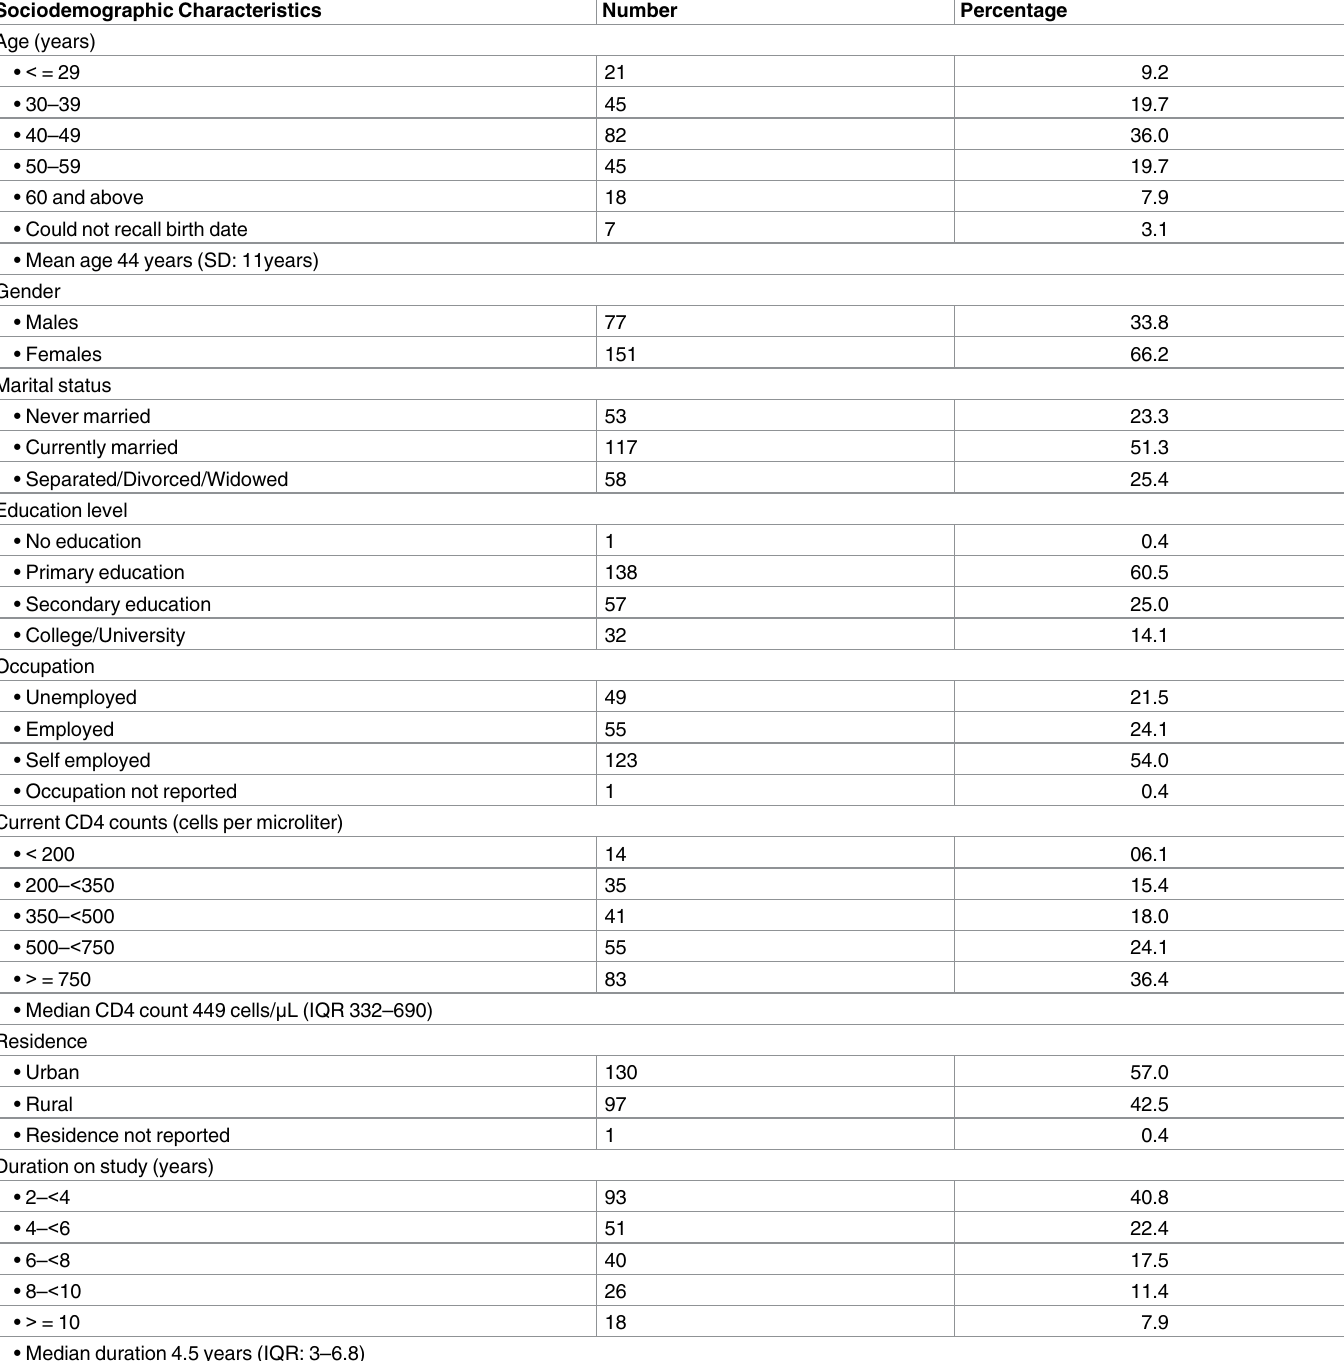
Table 2. Demographic characteristics of the participants (N =